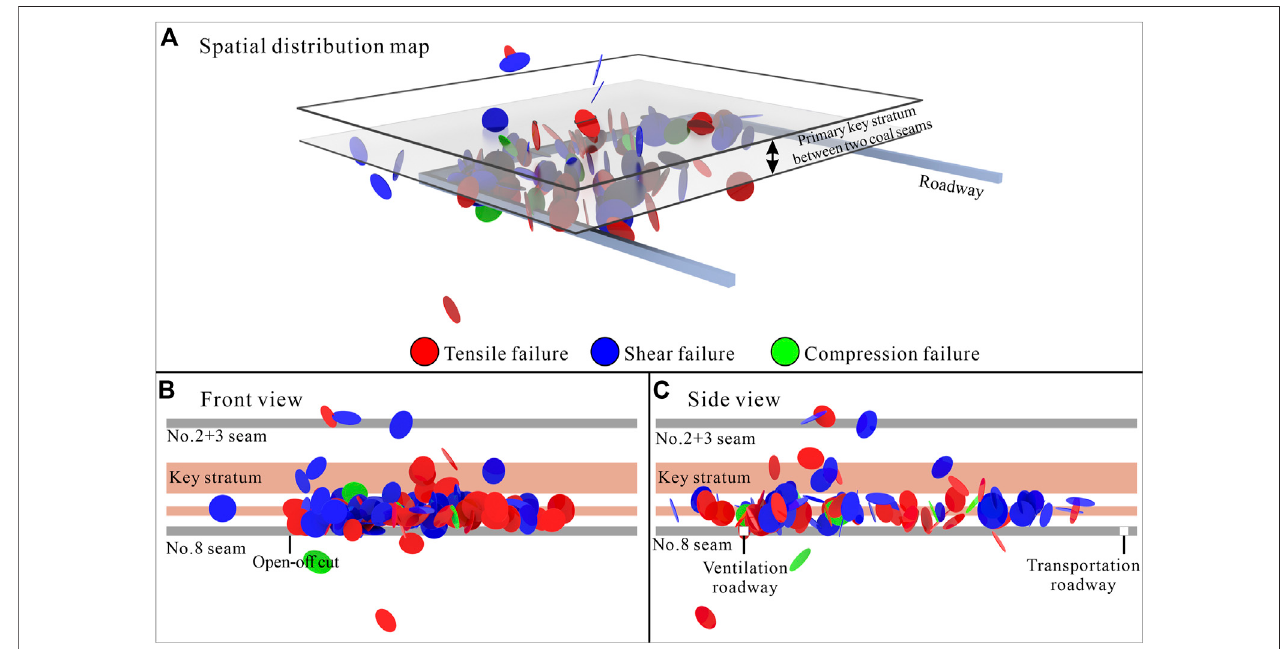
FIGURE 4 | Distribution of fractures derived from microseismic data of No. 18401